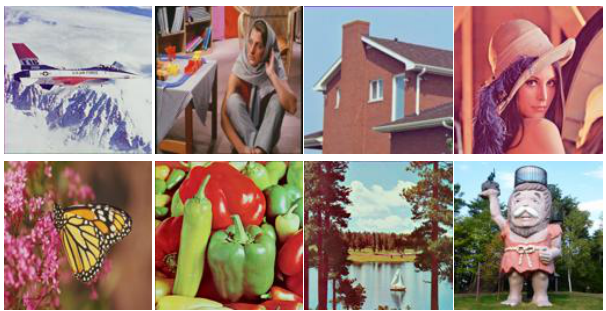
Figure 2. Description of the standard test